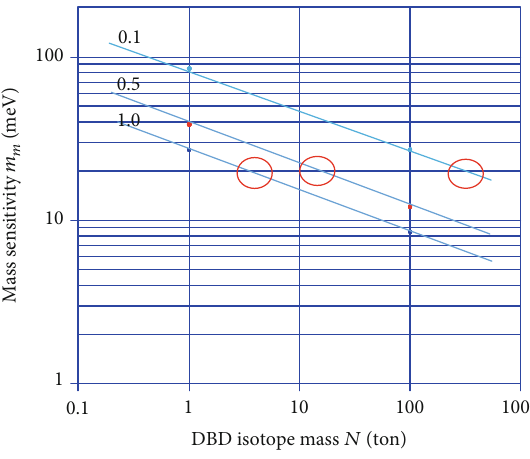
Figure 3: Neutrino mass sensitivities m a function of the total isotope-mass N . The exposure time is T = 5 y, and the nuclear sensitivity of m 0 = 20 meV , ε = 0 : 55 , d 0 = 1 : 4 , and B = 1 /ty.